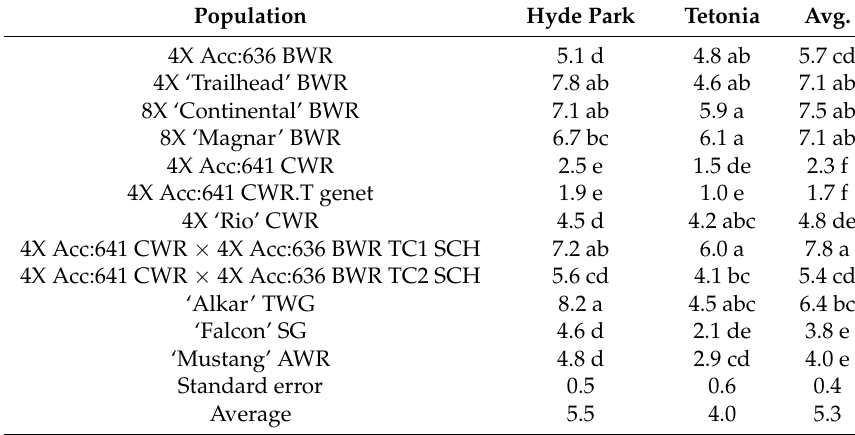
Table 3. Dry matter yield (Mg · ha − 1 ) for tetraploid (4X) and octoploid (8X) forms of basin wildrye (BWR), creeping wildrye (CWR), CWR × BWR single-cross hybrids (SCH), Altai wildrye (AWR), switchgrass (SG), and tall wheagrass (TWG) in dryland range plots evaluated over four years and two locations (Hyde Park, Utah and Tetonia, Idaho). Differences among groups of entry means are indicated by lettered ranks, within table columns, based on least significant difference. Population Hyde